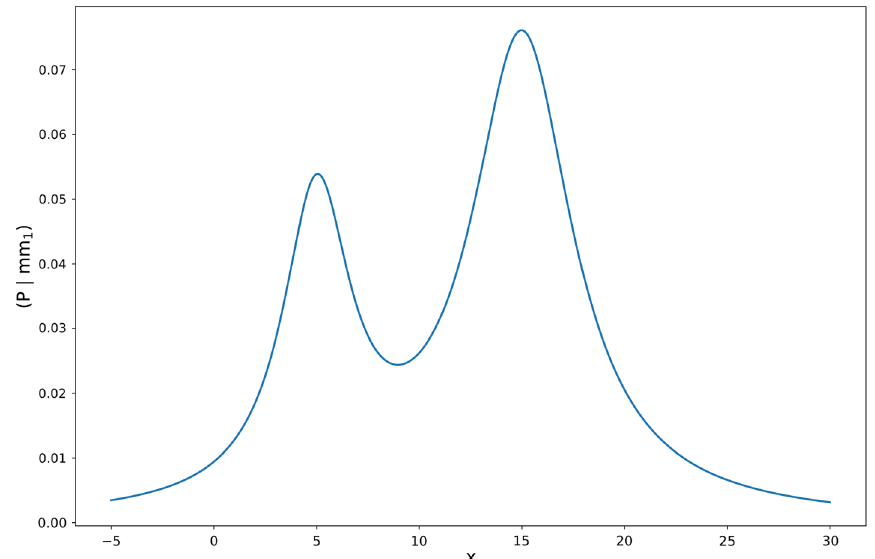
Fig. 7 Exemplary mixture model. Source : Own